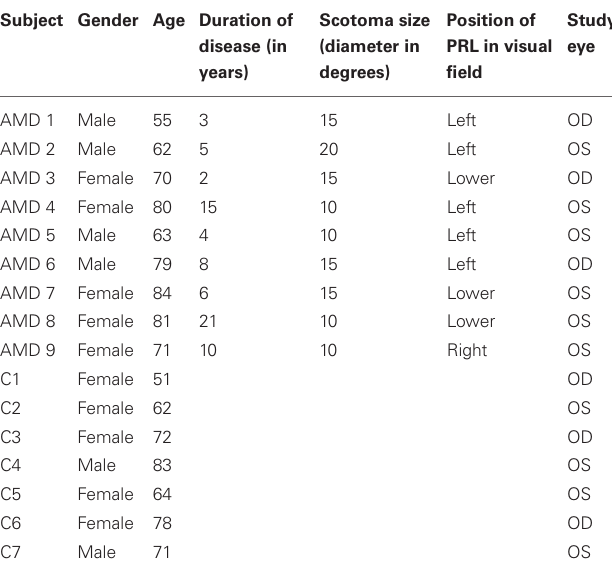
Table 1 | Demographic characteristics of AMD patients (AMD 1-AMD 9) and matched controls (C 1–C 7) referring to their gender, age, duration of disease, scotoma size, study eye and location of the PRL in patients’ visual